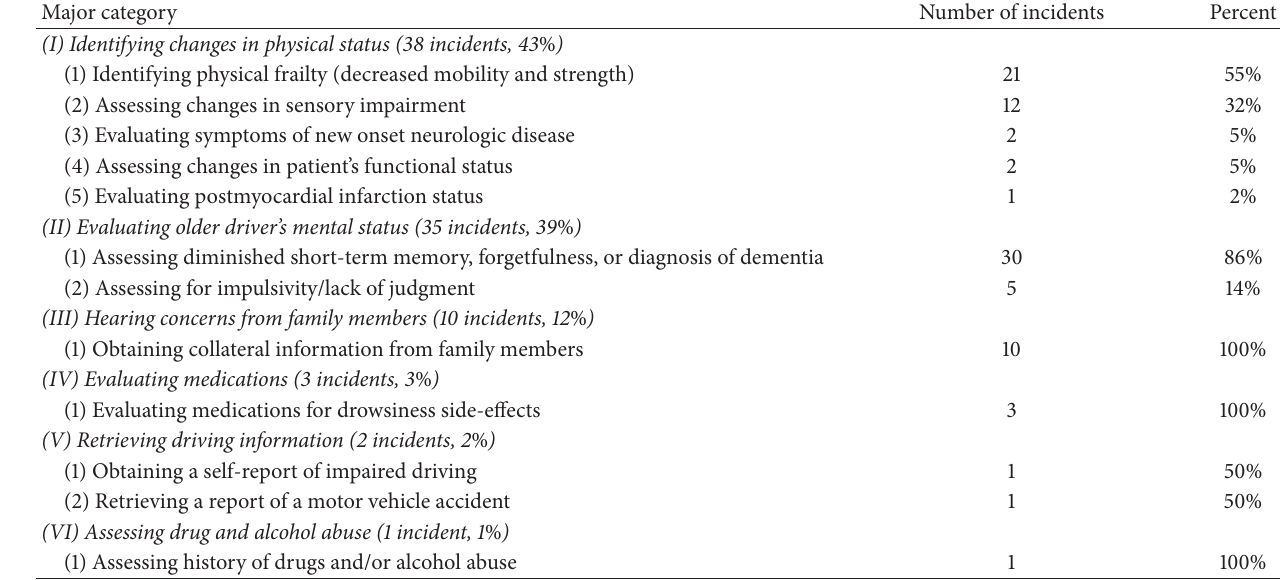
Table 1: Major categories of nurse practitioner strategies for determining when to intervene with an older driver ( 𝑛 = 89